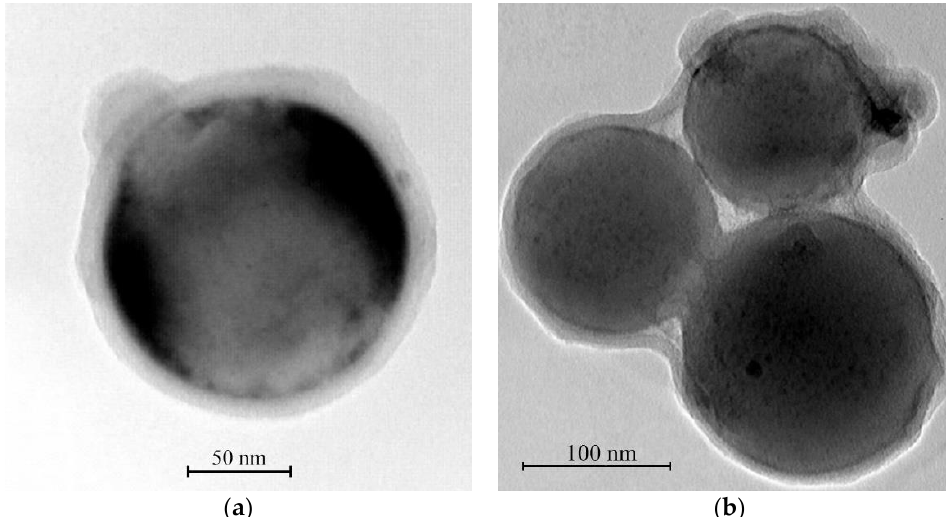
Figure 10. TEM images of modified aluminum nanopowder with magnification ( a ) ×12 × 10 5 times ( b ) and ×60 × 10 4 times.